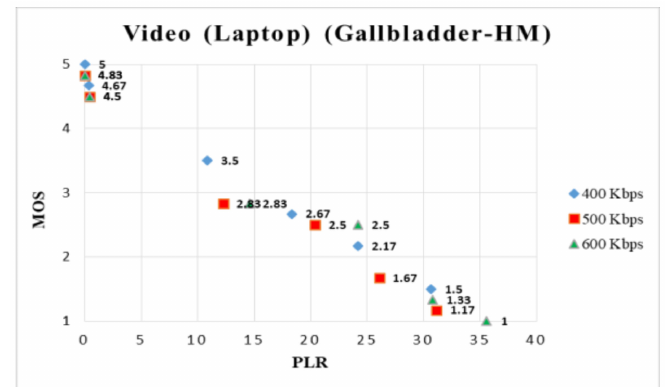
Figure 11. MOS ratings for gallbladder ultrasound (HM) on laptop.